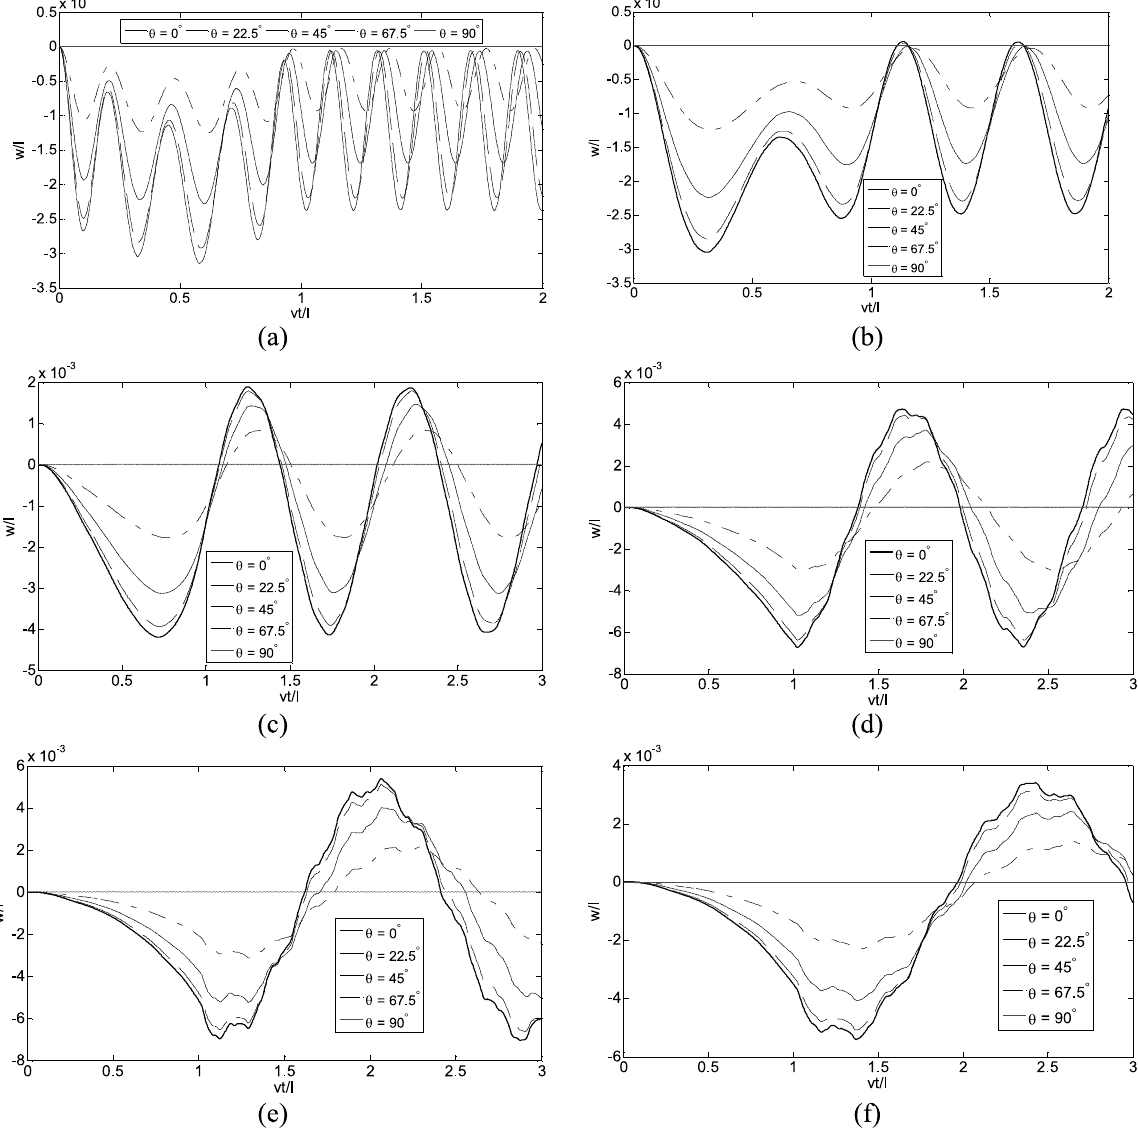
Fig. 7. Time histories for normalized mid-span de fl ection for m = 0.5 ρAl (kg). (a) α = 0.1, (b) α = 0.25, (c) α = 0.5, (d) α = 0.75, (e) α = 1, (f) α = 1.25. (—) θ = 0 ◦ , (– –) θ = 22.5 ◦ , (- - -) θ = 45 ◦ , (– - –) θ = 67.5 ◦ , (–) θ = 90 ◦